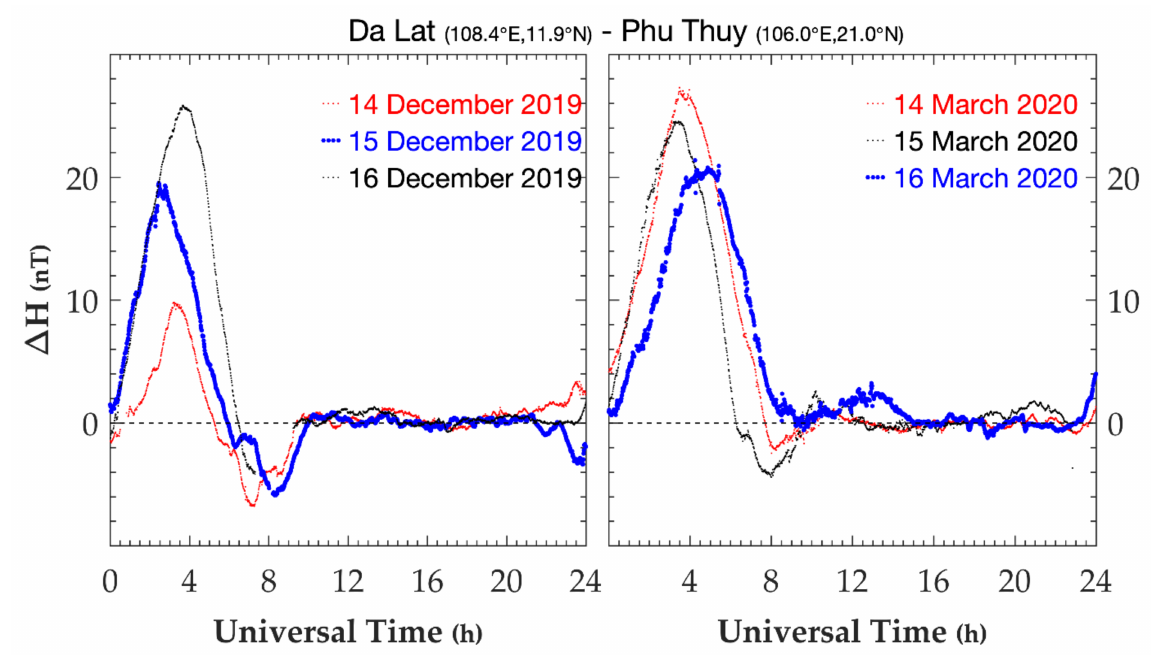
Figure 11. The equatorial electrojet (EEJ) during 14–16 December 2019 and 14–16 March 2020. The EEJ is indicated by ∆ H, the intensity difference of the horizontal magnetic field component recorded at Da Lat, an equatorial magnetometer, and at Phu Thuy, an off-equatorial